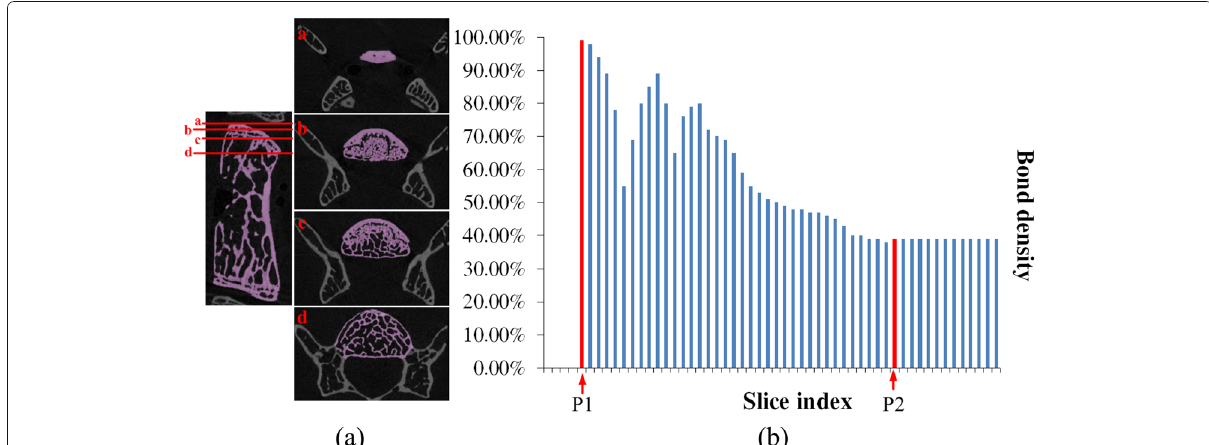
Fig. 5 Endplate region extraction. a Axial views (right) of four typical slices of index a, b, c, and d (left). b Bone density variation among a sequence of slices. The horizontal axis is the slice index, the vertical axis is the bone density value accordingly, P 1 and P 2 indicate the range of the result